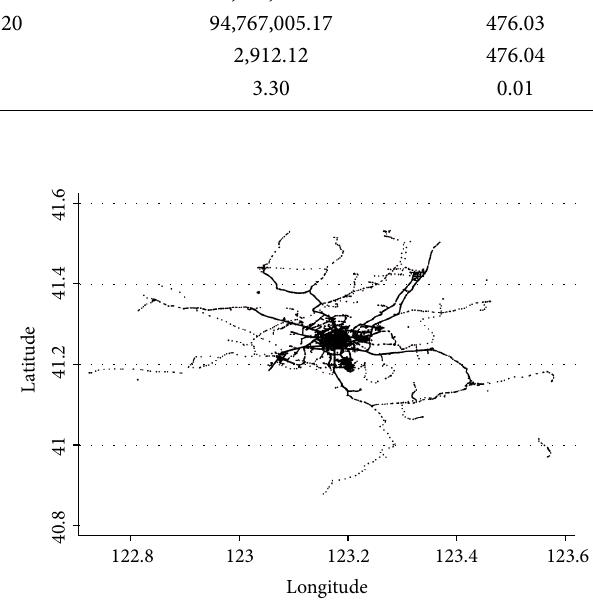
Figure 14: Taxi positions of